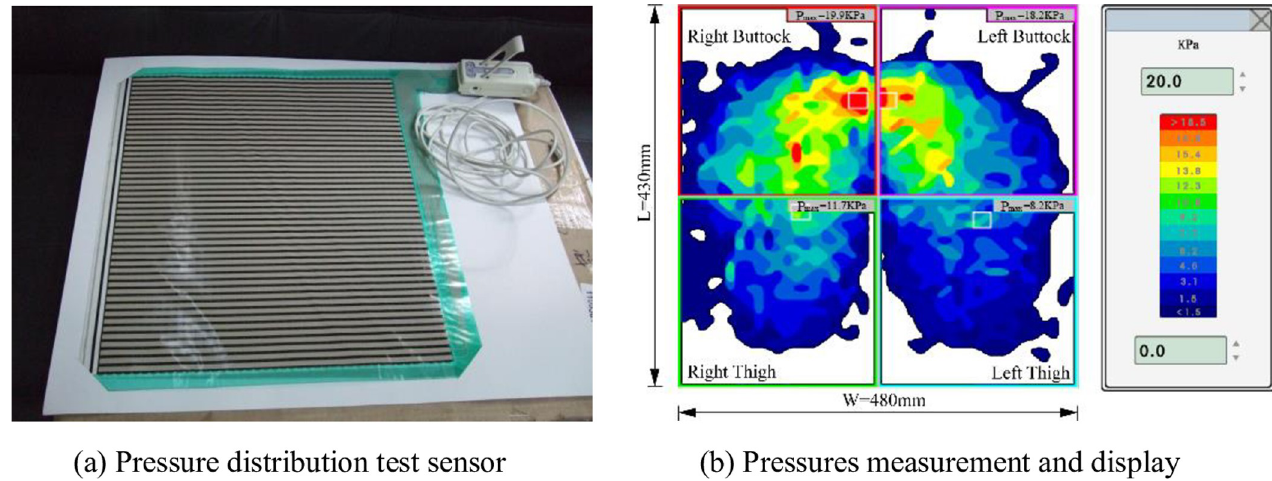
Fig 9. Tekscan production pressure distribution measurement system. (a) Pressure distribution test sensor and (b) Pressures measurement and display.